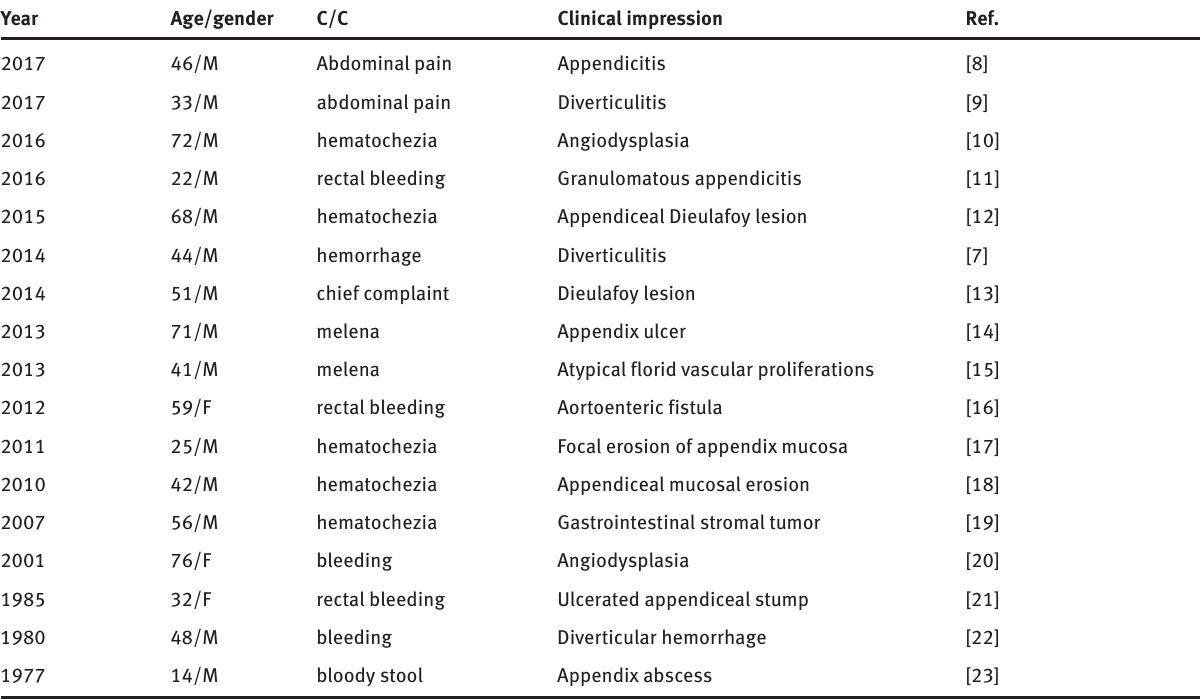
Table 1: The information of the 17 articles published about appendix bleeding.